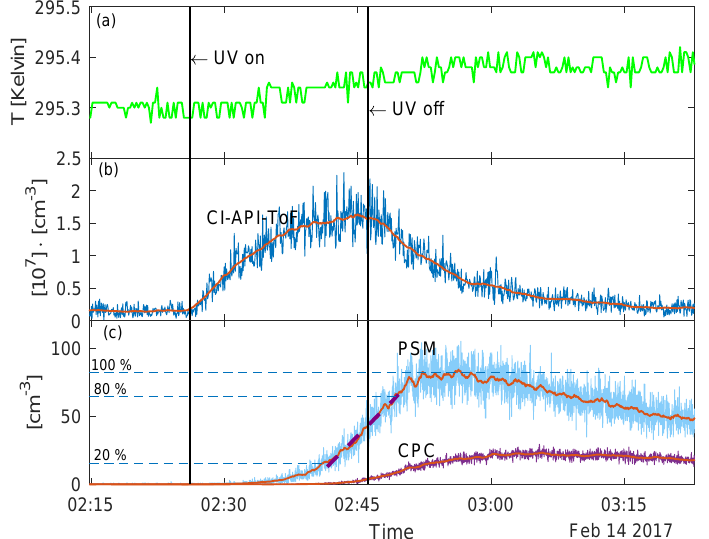
Figure 3. Run sequence for an experiment with 22% UV and N = 8400[cm − 3 ]. The vertical lines show when the UV lamps were turned on and off. (a) Temperature in the chamber. (b) H 2 SO 4 concentration measured with the CI-API-ToF and 50-point moving average shown in red. (c) Aerosol particle concentration measured with PSM and CPC (before the loss correction). The 50-point moving average is shown in red. The purple dashed line on top of the PSM data shows the linear fit between 20 and 80 of the maximum concentration. The gradient of this fit (on the loss-corrected data) was used as the nucleation